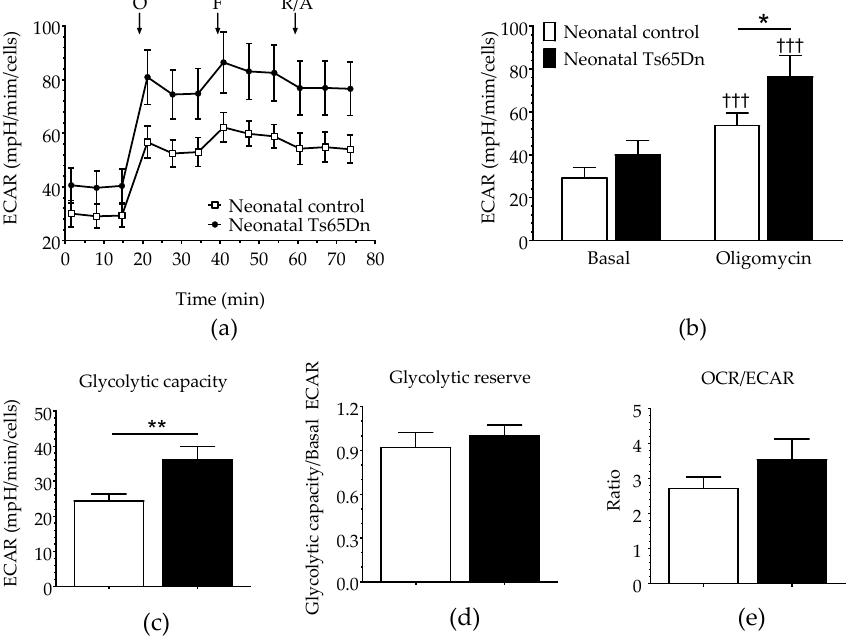
Figure 3. Glycolysis in astrocytes derived from neonatal Ts65Dn and control mice. ( a ) Real-time changes in extracellular acidification rate (ECAR) after treatment with oligomycin (O), FCCP (F), and rotenone/antimycin A (R/A). ( b ) Basal and oligomycin ECAR (ECAR after oligomycin treatment) derived from ECAR profiles. ( c ) Glycolytic capacity (calculated by subtracting the basal ECAR value from the ECAR value after oligomycin treatment). ( d ) Glycolytic reserve (calculated by dividing the glycolytic capacity by the basal ECAR value). ( e ) OCR/ECAR ratio. Data are expressed as the mean ± SEM ( n = 10–13 independent experiments with samples in triplicate); * p < 0.05, ** p < 0.01, and ††† p < 0.001 indicate significant differences between before and after treatment for a given genotype.